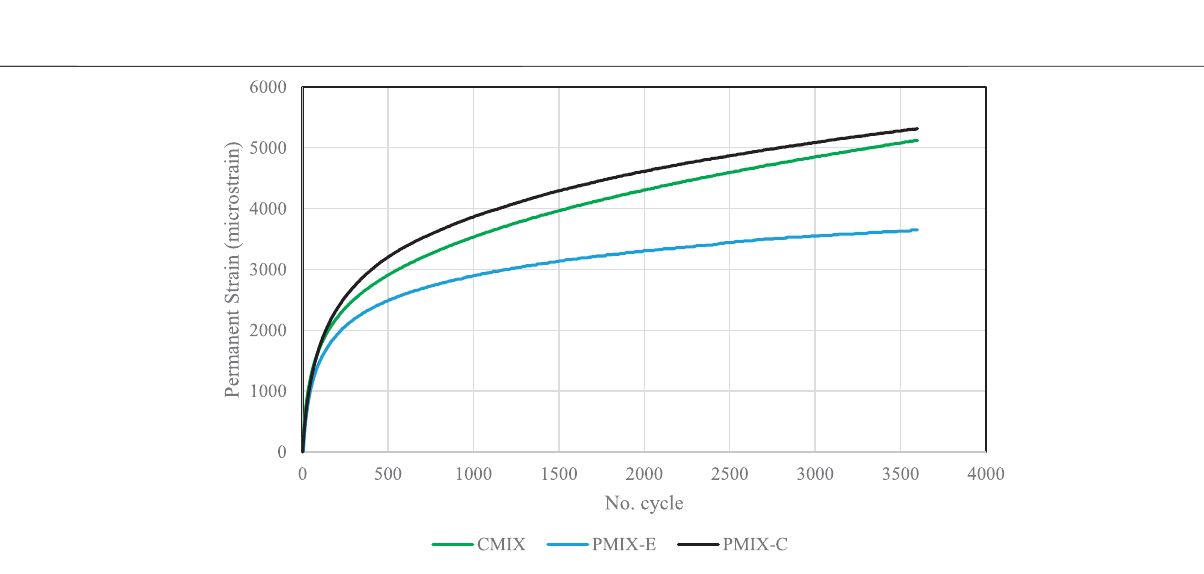
FIGURE 9 | Permanent strain vs. the number of cycles of the control, PMIX-C and PMIX-E mixtures.